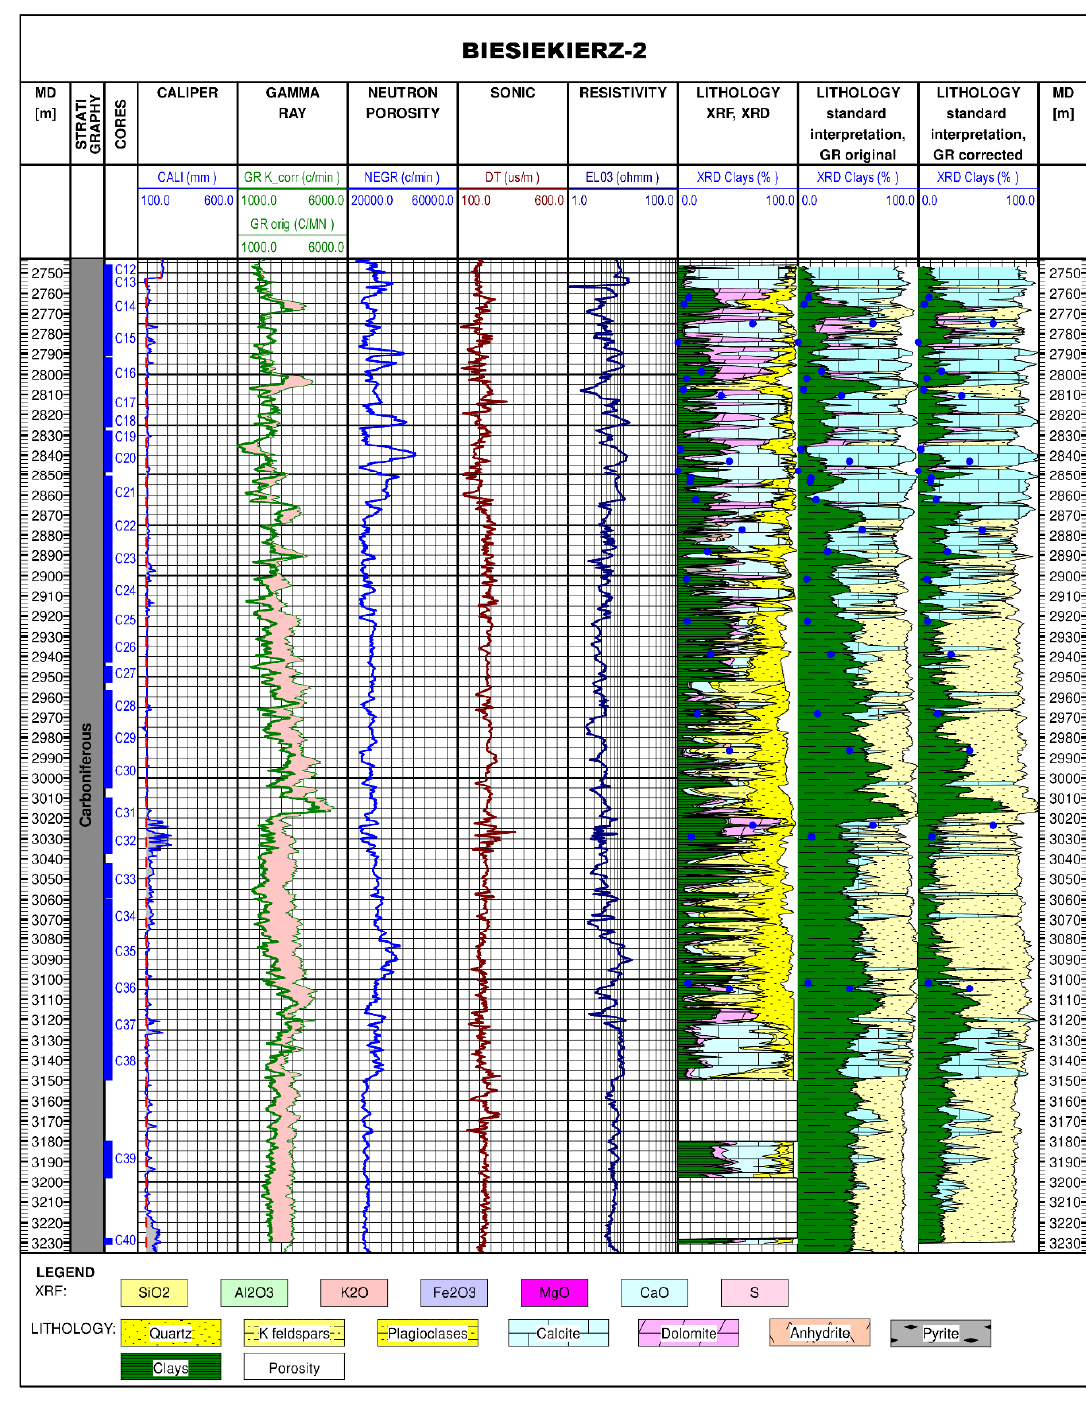
Figure 18. Comparison of lithological profile reconstruction results with a standard interpretation of geophysical logging for the Biesiekierz-2